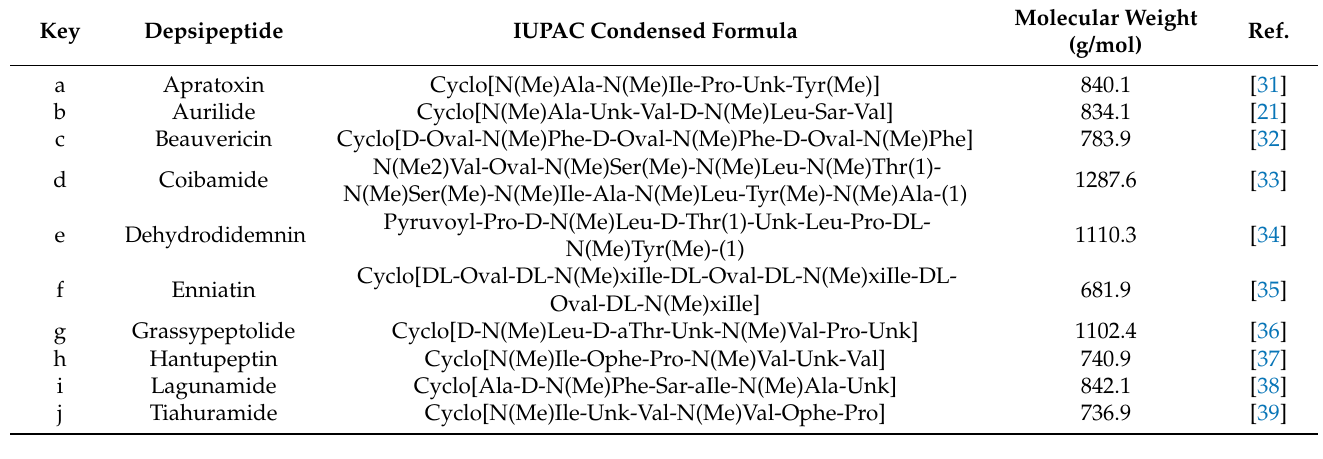
Table 1. Formula and molecular weight of depsipeptides inducing apoptosis in tumor cells.